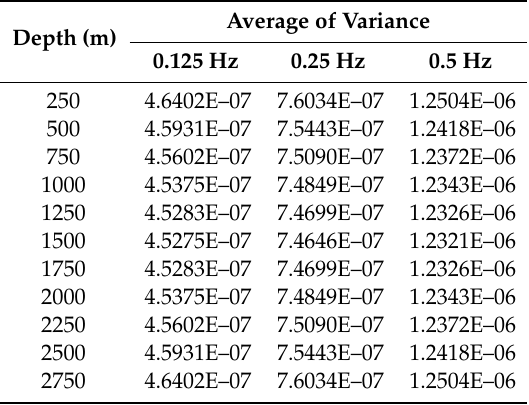
Table 2. The average of variance of EM responses (frequencies: 0.125, 0.25, and 0.5 Hz) at all tried depths of hydrocarbon (250–2750 m with an increment of 250 m each). Average of Variance Depth (m) 0.125 Hz 0.25